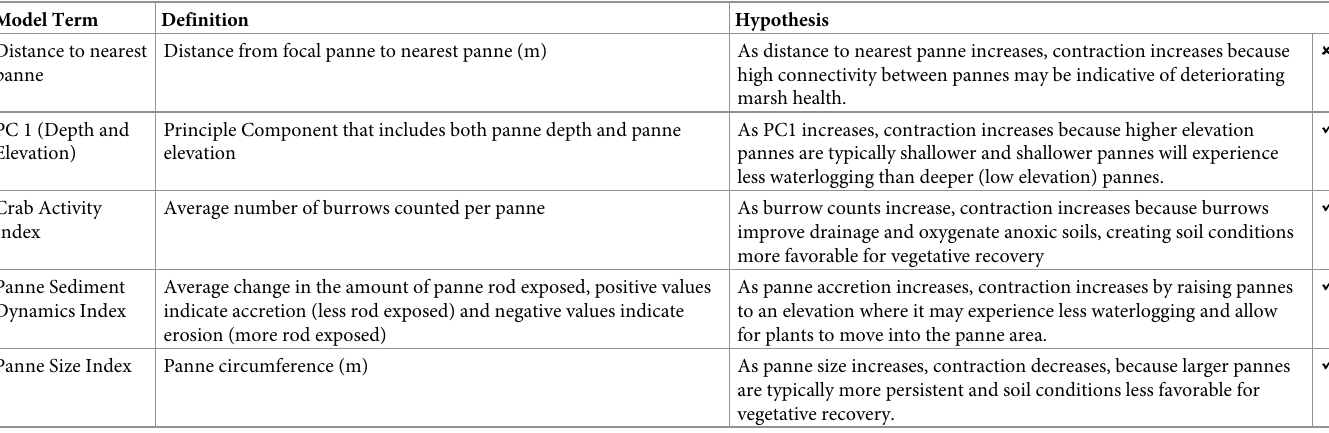
Table 1. Model terms, definitions, and hypotheses about panne